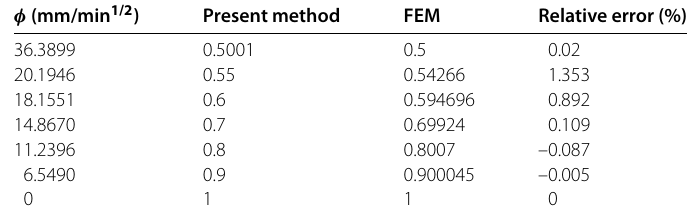
Figure 3 The changes of water profile for power law model. Dotted lines show the present approximations, and solid lines show the results by the